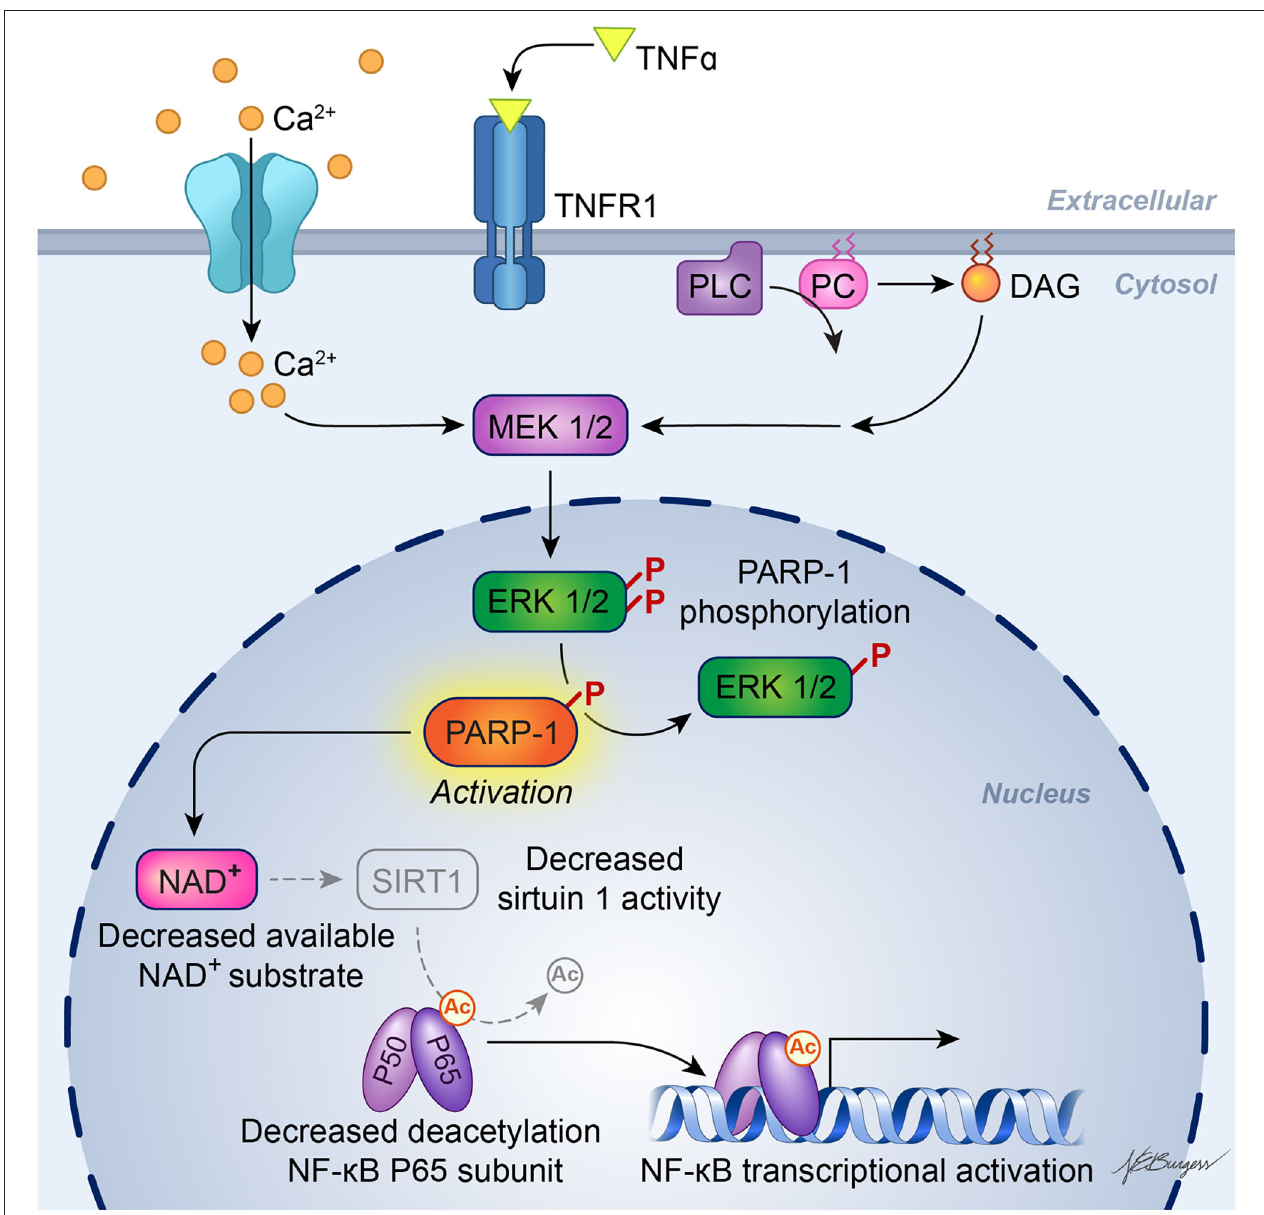
FIGURE 2 | Schematic diagram of PARP activation in inflammatory signaling. Experiments in cultured microglia and astrocytes indicate that binding of TNF α to its receptor, TNFR1, leads to calcium influx and activation of phosphatidylcholine (PC)-specific phospholipase C (PC-PLC), resulting in formation of diacylglycerol (DAG) and downstream action of the MEK1/2-ERK1/2 pathway. ERK2 phosphorylation of PARP-1 increases PARP-1 activity, which then facilitates activation of NF- κ B transcription. One possible mechanism whereby PARP-1 facilitates NF- κ B transcription is by depleting NAD + , which is also used as a substrate by sirtuin-1. Sirtuin-1 normally keeps the P65 subunit of NF- κ B deacetylated, but a decrease in sirtuin-1 activity will result in acetylated P65, which enables NF- κ B transcription. [Adapted, with permission, from Vuong et al. (54) and Kaupinnen et al. (56)].